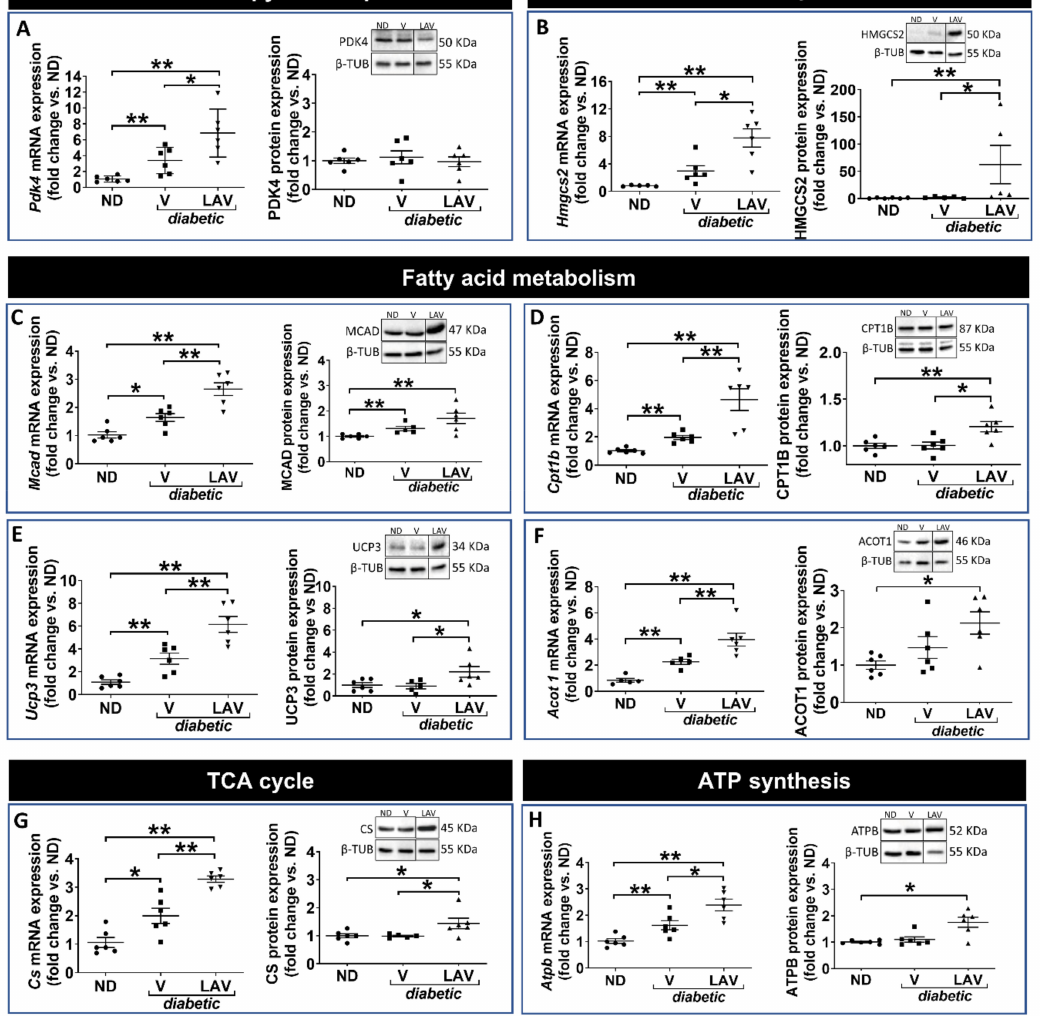
Figure 3. Focused transcriptomic analysis of mitochondrial metabolic targets. Graphs show the mRNA and protein expression levels of components involved in the regulation of mitochondrial pyruvate uptake (PDK4) ( A ); ketone biosynthesis (HMGCS2) ( B ); fatty acid metabolism (MCAD, CPT1B, UCP3, & ACOT1) ( C – F ); the TCA cycle (CS) ( G ); and ATP synthesis (ATPB). Data (fold changes vs. ND) are expressed as individual values and means ± SEM of n = 6 per group. * p < 0.05 and ** p < 0.01. Representative western blots show n = 1 sample per group, presented in the same order as in the graphs. Line within blots indicates non-adjacent lanes on the same membrane (see online Supplementary gels file S1). For clarity, mRNA data for Pdk4 , Hmgcs2 and Acot1 is the same as that presented in Figure